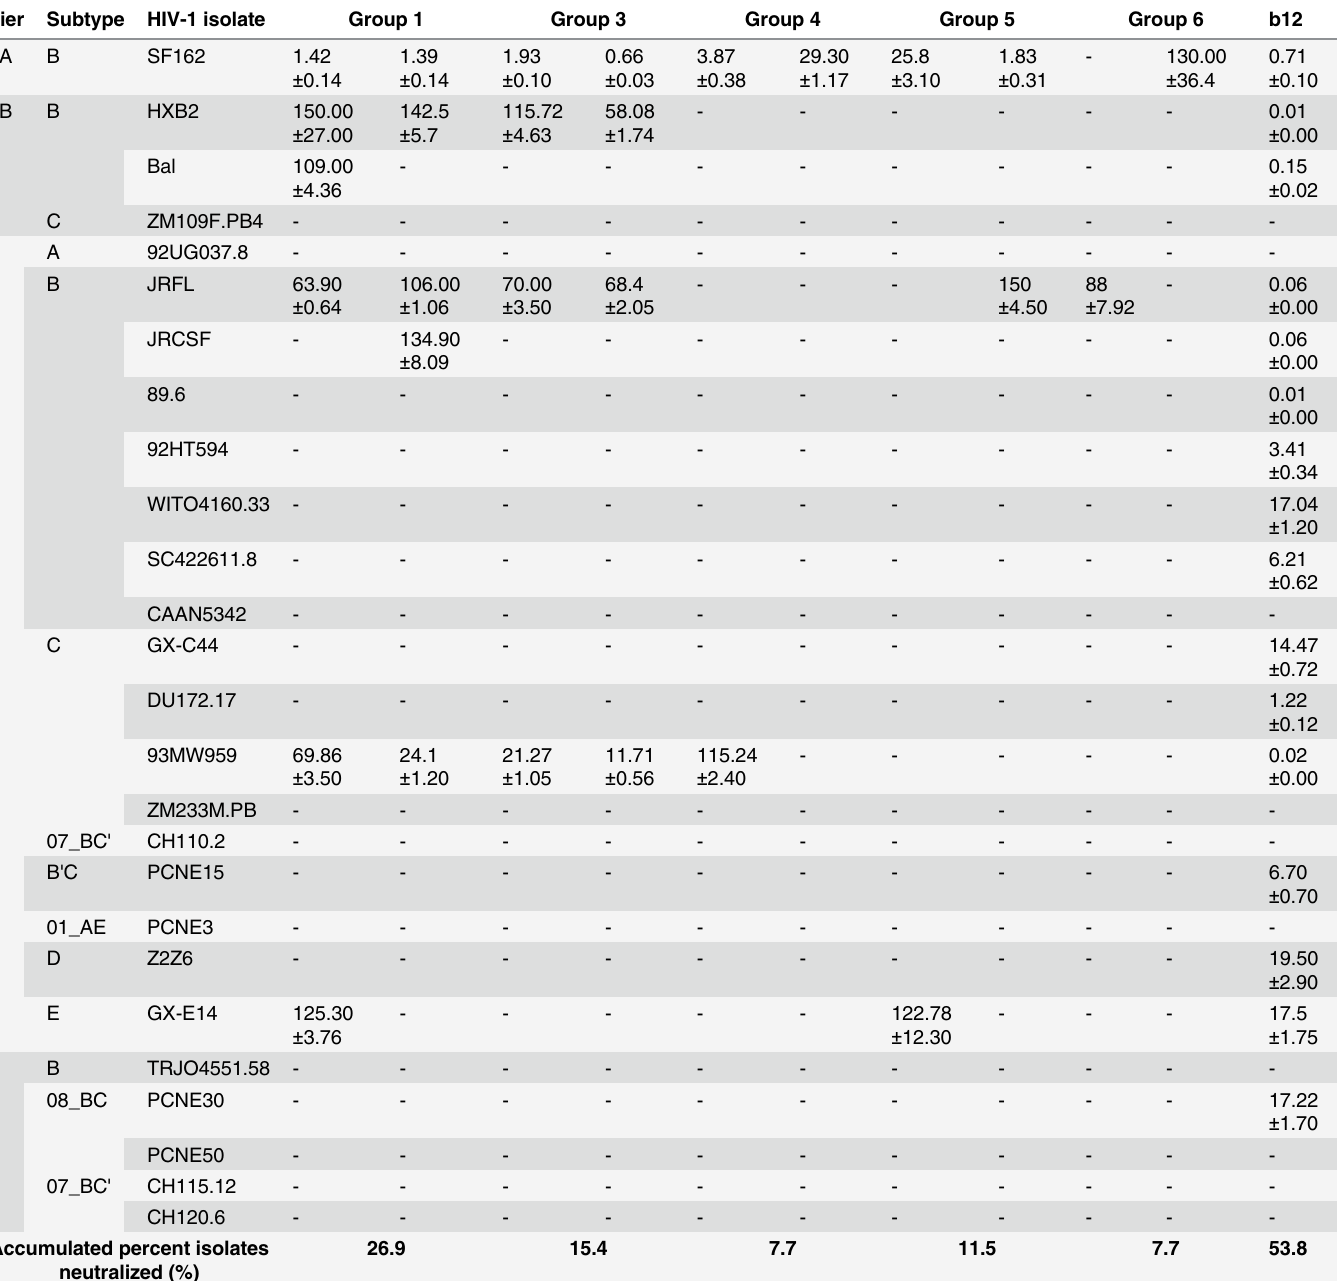
Table 3. Neutralization activities (IC50s) of the immune rabbit IgGs in the TZM-bl